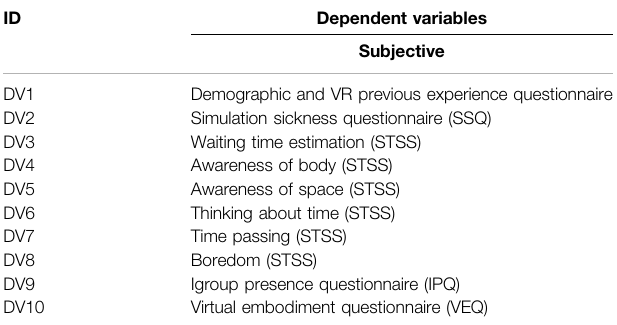
TABLE 1 | Measures and dependent